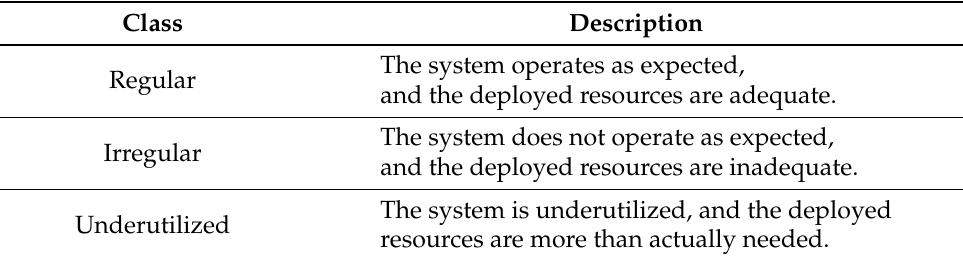
Table 1. Classification of operational states. Class Description The system operates as expected, Regular and the deployed resources are adequate. The system does not operate as expected, Irregular and the deployed resources are inadequate. The system is underutilized, and the deployed Underutilized resources are more than actually